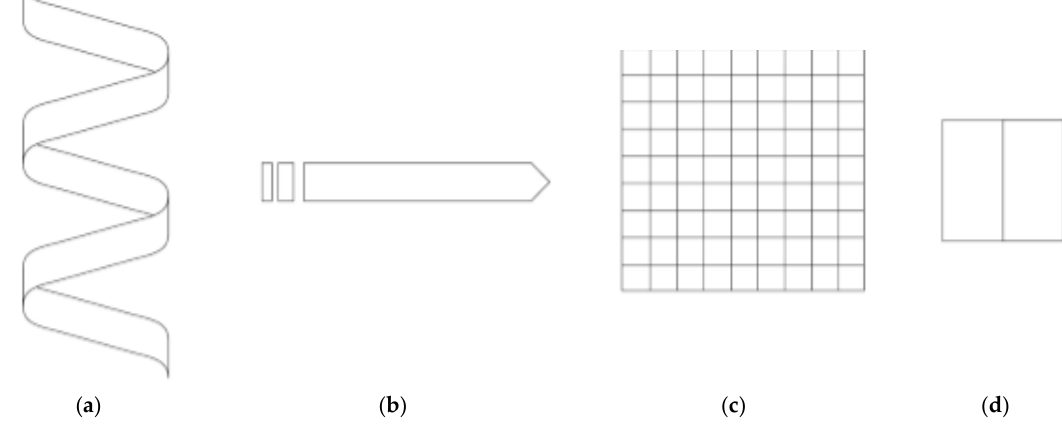
Figure 2. Several ways to represent “time” privileging different pertinences: ( a ) Cyclical and re-iterative features of time; ( b ) A linear and sequential model of time; ( c ) Deformable and non-sequential representation of time; ( d ) Binary distinction of “what is perceivable now” and “what is